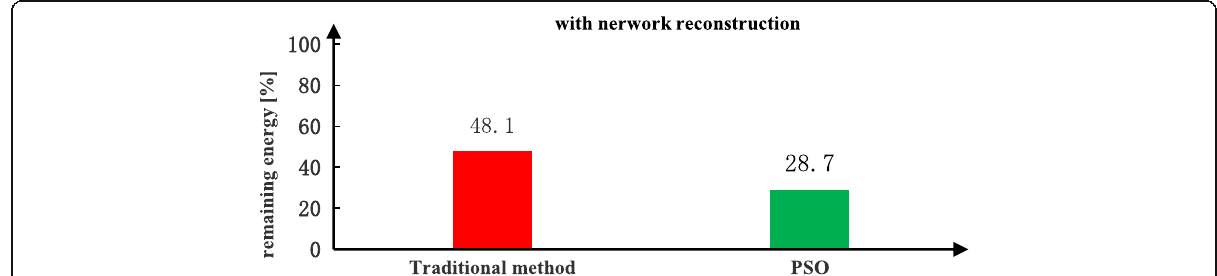
Fig. 13 Comparison of remaining energy. This figure shows the comparison of the performance in term of the remaining energy at the end of network lifetime when the reconstruction method with fixed threshold is